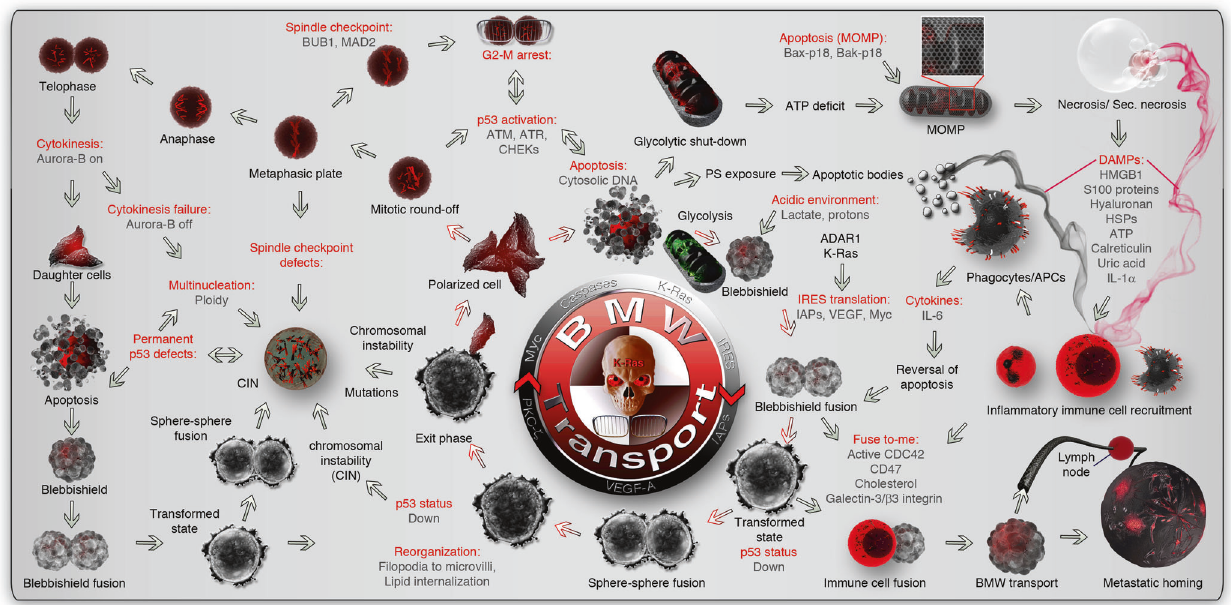
Fig. 2 Alternative cell death process-dependent BMW pathway for metastasis. The metastatic events start with the initiation of the reversible cell death process. Upon initiation of apoptosis, an acidic environment, and enhanced endocytosis initiate the cell fusion behavior in apoptotic cells. ARAR1 and K-Ras drive the protection of anti-apoptotic mRNAs (IAPs) and IRES translation. Membrane fusion initiates the reassembly of apoptotic blebs to form blebbishields. Blebbishield-blebbishield fusion results in the transformed spheroid state with multiple copies of genomes inside. The nuclear membrane disappears during this stage. Depending on mitochondrial dysfunction and ATP scarcity, the cells can enter an irreversible secondary necrotic state. In parallel, DAMPs (indicated by black or maroon smoky trails from apoptotic and secondary necrotic cells, respectively) attract immune cells to the scene promoting an immune cell-cancer cell hybrid (analogous to a transformed state). The hybrids acquire migratory capacity and use homing signals of immune cells to reach target organs (BMW transport) and use immune cell identity to evade the immune system to establish metastasis. During the transformed spheroid state, p53 is suppressed from expression to suppress apoptosis. The transformed spheres then reorganize their fusogenic lipid membranes (retracted inside from the surface) and reform the nuclear membrane and release individual polarized cancer cells outside the spheroid (Exit phase). The cells released from the transformed state can be polyploid, aneuploid, or diploid to augment genomic instability and heterogeneity. The exited cells may undergo further round of apoptosis due to reactivation of genomic checkpoints, undergo cell division, or undergo cell cycle arrest to augment genomic instability. DAMP damage-associated molecular patterns, MOMP mitochondrial outer membrane permeabilization, BMW transport blebbishield-mediated metastatic-witch transport, PS phosphatidyl serine, CIN chromosomal instability, HSPs heat-shock fi lopodia 68,69 and RhoA regulates AJ disassembly. 70 Activation of